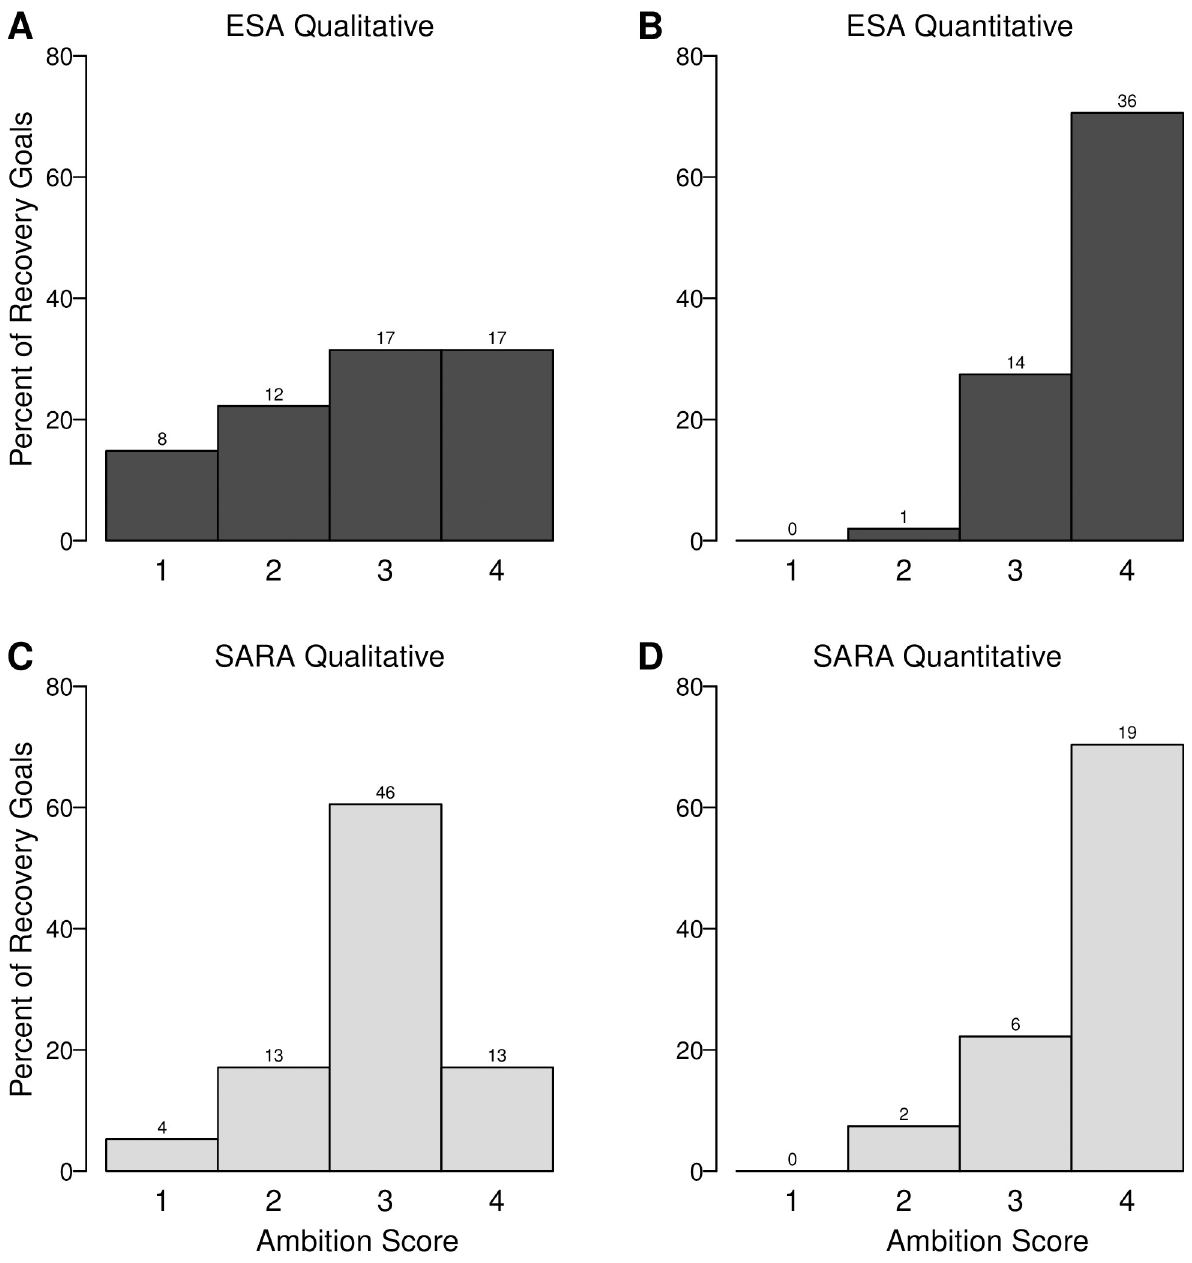
Fig 1. Ambition of qualitative and quantitative recovery goals for species (n = 208) listed under the United States’ Endangered Species Act (ESA) and Canada’s Species at Risk Act (SARA). Bars show the percent of recovery goals with ambition scores 1–4 for (A) qualitative goals under the ESA, (B) quantitative goals under the ESA, (C) qualitative goals under SARA, and (D) quantitative goals under SARA. Ambition of recovery goals within published recovery documents was scored on a scale from 1 to 5; however, no goals qualified for an ambition score of 5 (see Methods). The number of recovery goals in each category is displayed above each